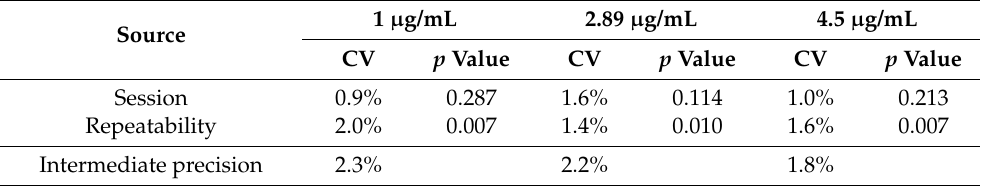
Table 3. Variance component analysis for reproducibility of HPAEC-PAD